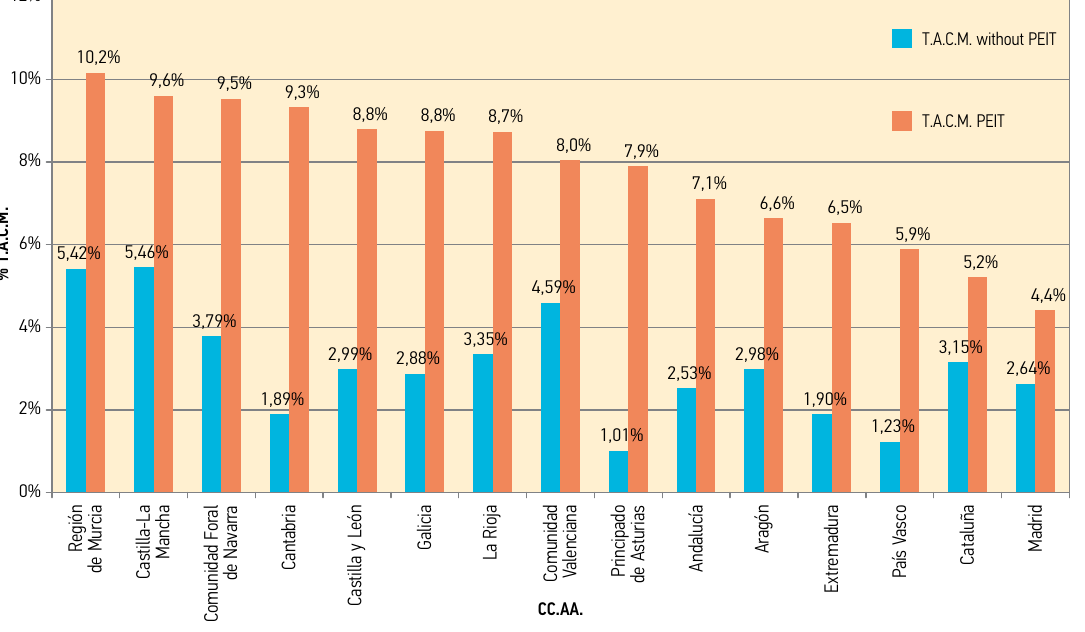
Fig. 7. Comparison of average annual accumulative rates of GVAbp at constant prices (notes: base 2005 = 100; period – 2005–2020)